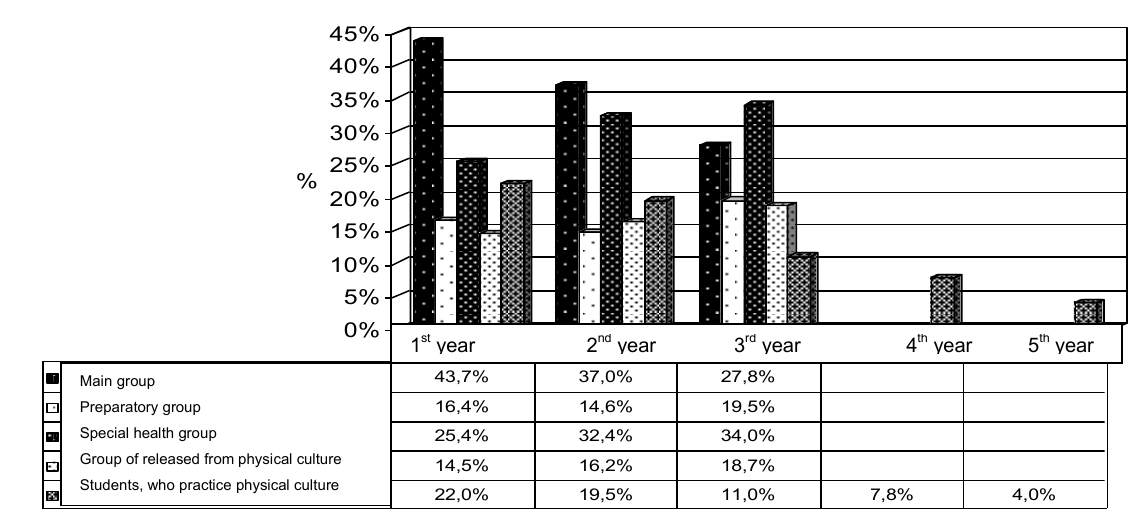
Fig.3. Dynamic of distribution of students by health groups and quantity of students, who practice physical culture additionally (PE – physical exercises, PC – physical culture).